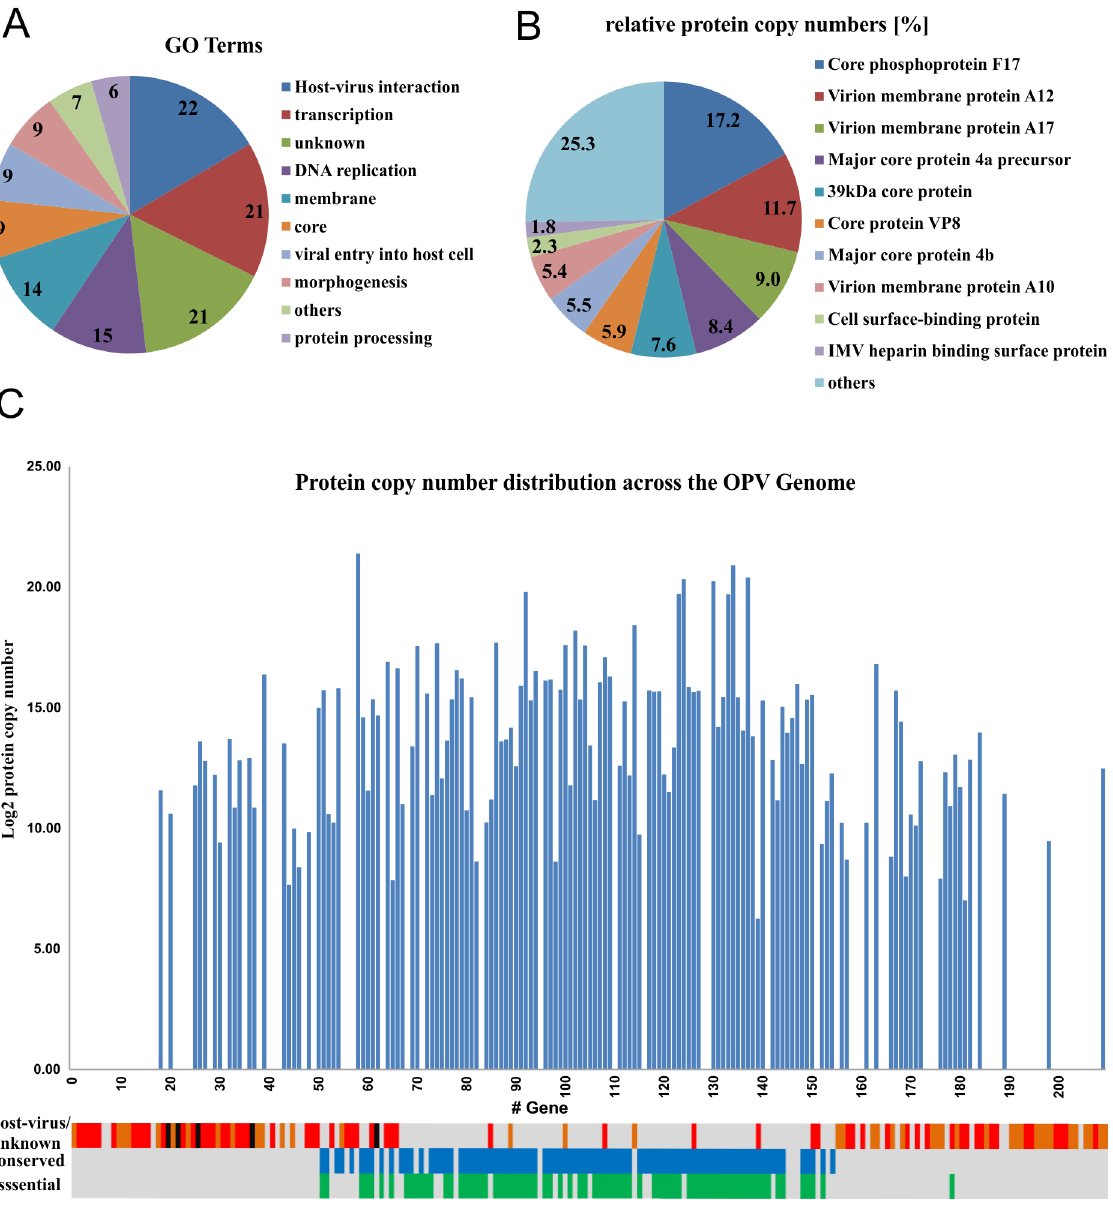
Fig 1. Common VACV and CPXV mature virion proteome. The common VACV and CPXV mature virion proteome consists of 133 proteins. The gene ontology terms of these proteins are grouped according to their frequency (A). The relative amount of protein copy numbers of the ten most abundant viral proteins named after their CPXV GRI-90 homologue is shown in (B). The protein copy numbers of the common proteins are plotted on a logarithmic scale (basis = 2) against the gene position within the genome of the reference sequence CPXV strain GRI-90 (C). Below the x-axis, the distribution of essential (green), conserved (blue) and host-virus interactors (orange, host range factors are black) as well as uncharacterized proteins (red) within the linear refernce genome is